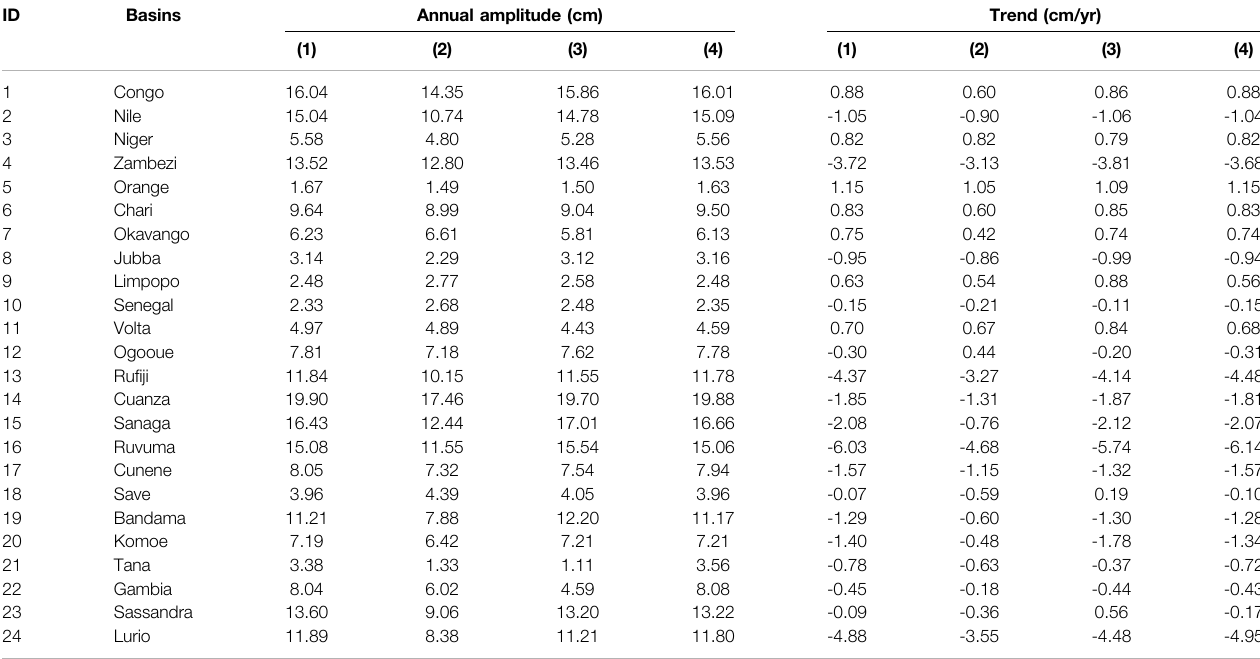
TABLE 3 | Annual amplitudes and trends of 24 basins over Africa derived from different processing procedures: (1) true signals derived from ESM HIS model; (2) 500 km Gaussian Filtering; (3) Forward modeling; (4) Improved Forward modeling. ID Basins